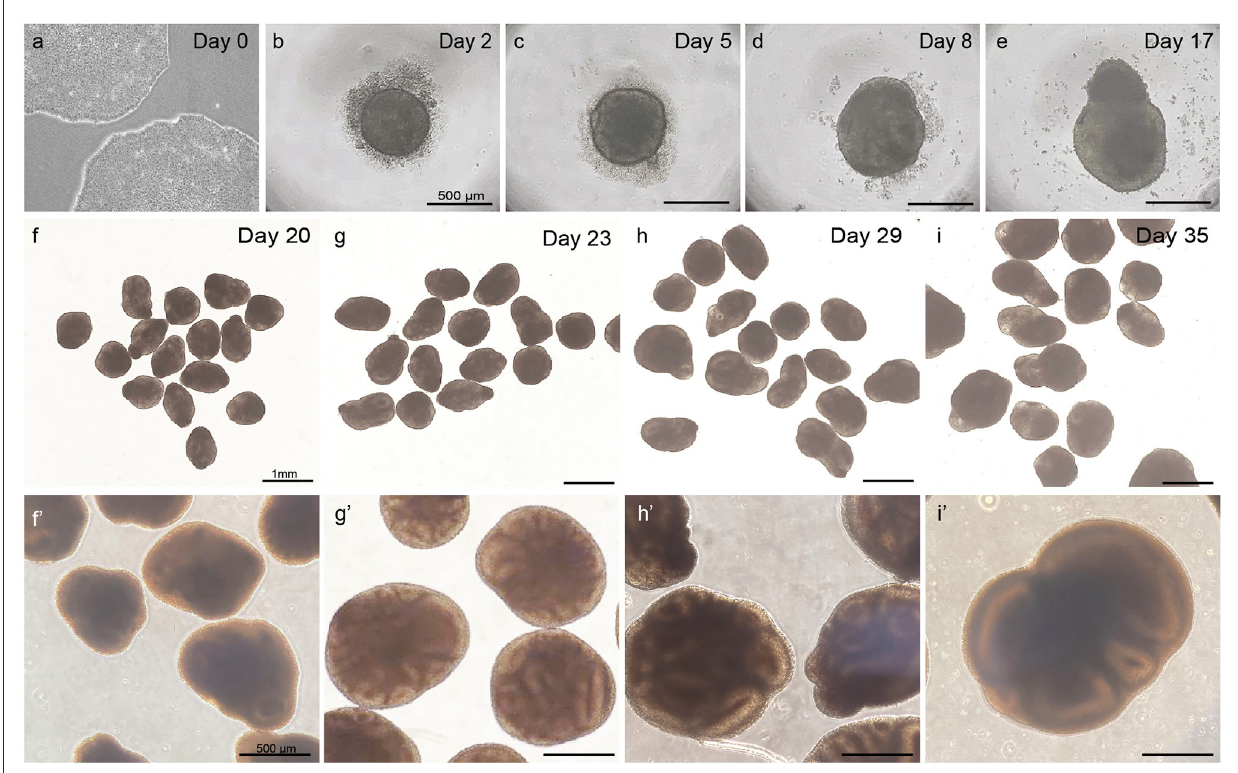
FIGURE3 Overview of different steps in embryoid body and cortical organoid development from PSCs. Healthy PSCs (a) . The scalebar in panels (b–e) represents 500 µ m; the scalebar in panels (f–i) represents 1mm; the scalebar in panels (f ′ –i ′ ) represents 500 µ